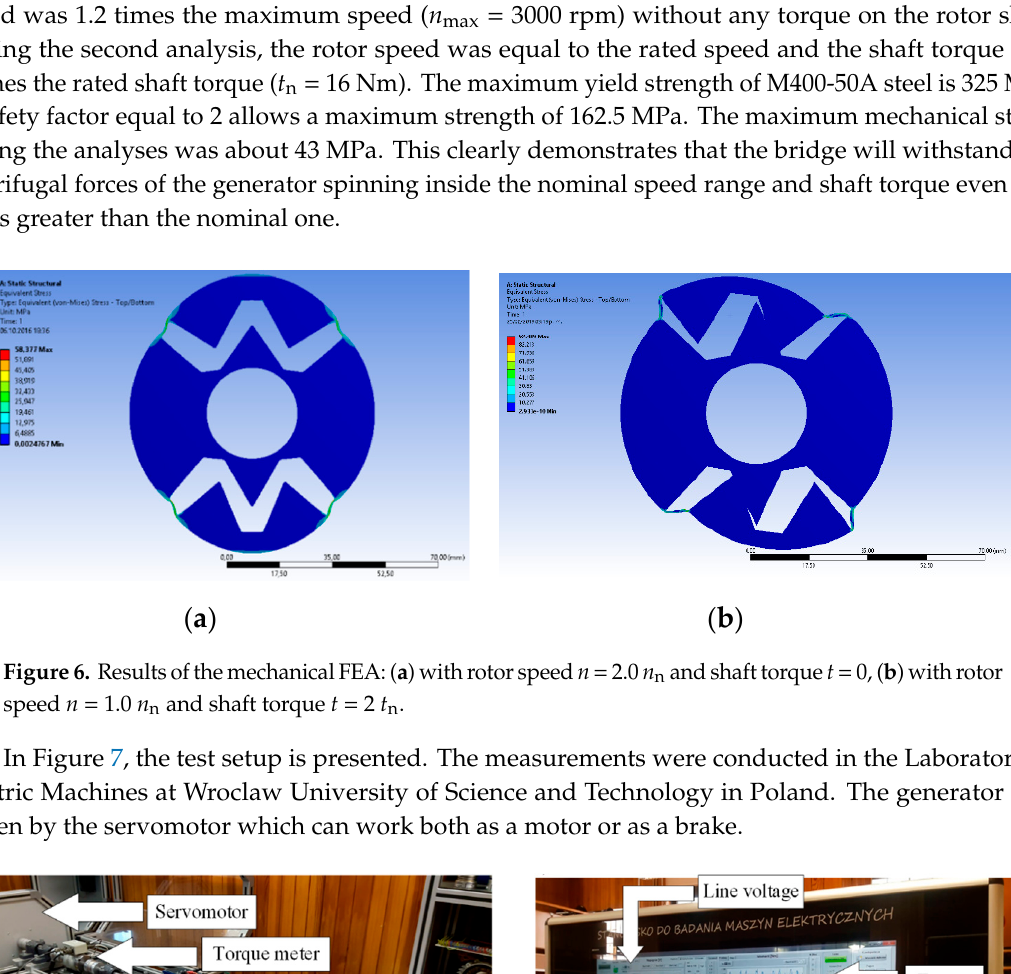
Figure 7. Laboratory: ( a ) test bench and ( b ) measurement’s display interface.